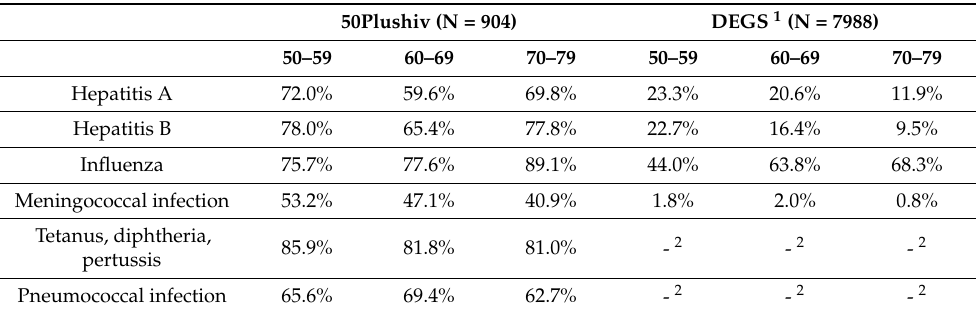
Table 3. Self-reported coverage of vaccinations among people aging with HIV in Germany (50plushiv) and a nationally representative sample of the German general population (DEGS1 1 ) [20] by age group.